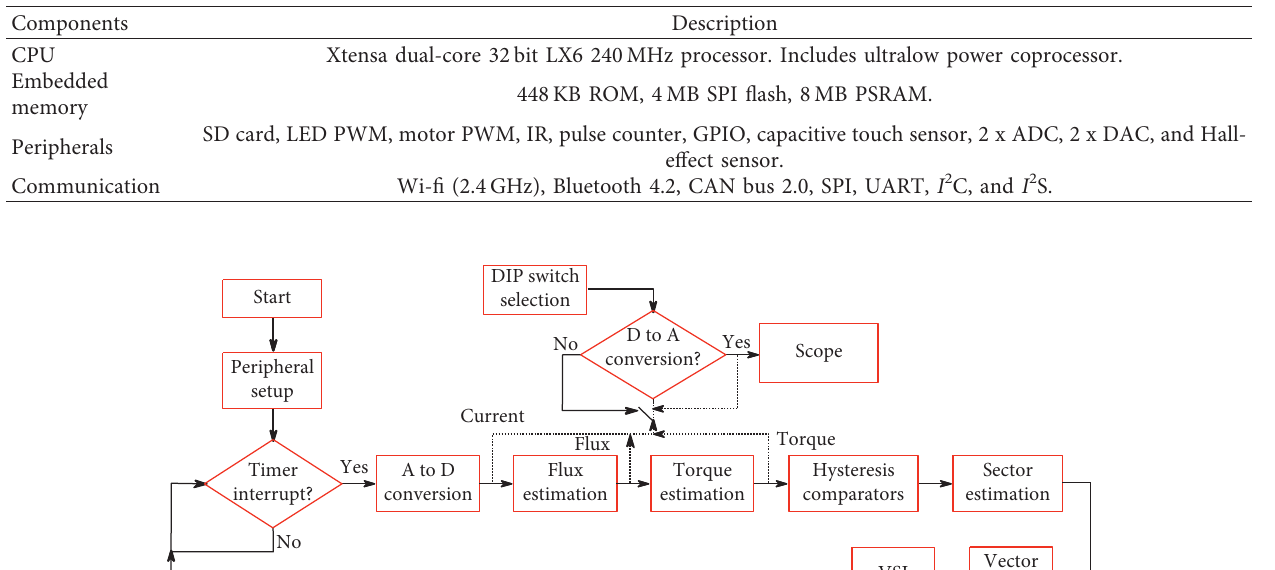
Table 3: ESP32-WROVER-B specifications and peripherals.